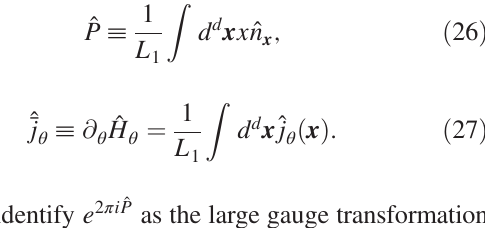
FIG. 2. (a) The probability amplitude for qL ¼ 10 , ξ ¼ 1 θ ¼ 0 . The inset illustrates the setup. (b) P (gray line) and ˜ P (black line) as a function of ξ for qL ¼ 10